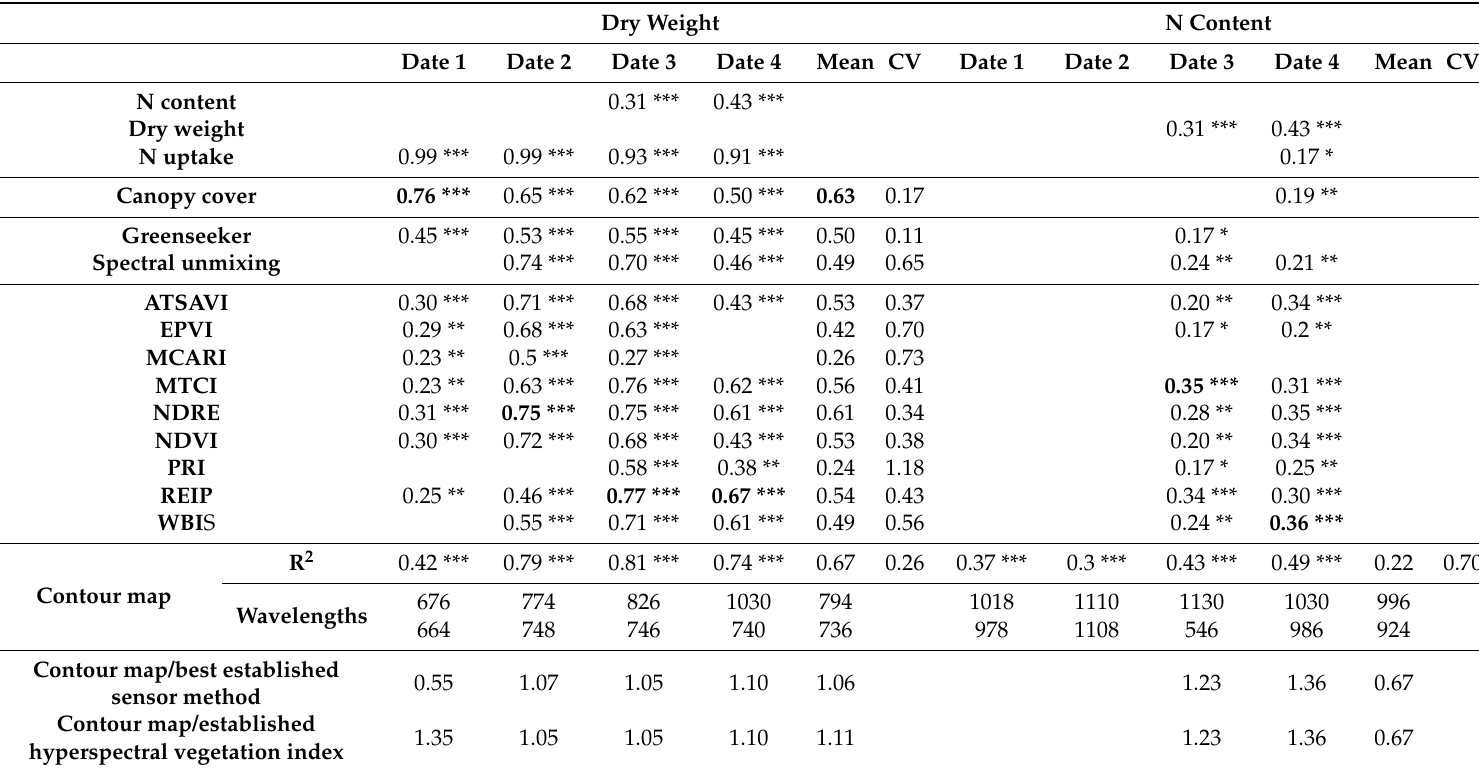
Table 3. Squared Pearson correlation coefficients (R 2 ) and significance levels (<0.05) for linear relationships of the sensor methods with canopy traits for four measurement dates as well as pairwise relationships of canopy traits. The R 2 of the best established sensor method per canopy trait is highlighted in bold for each date. Non-significant relationships are not shown. Contour map results refer to the maximum R 2 extracted from all possible pairwise normalized difference indices. For each trait*sensor method combination, the mean and coefficient of variation (CV) of the R 2 was calculated across the four days including non-significant relationships, except for NC because the correlations were often not significant. For contour maps, however, the values refer to the maximum of the mean contour map matrix as averaged over four days and the CV of the respective index for accounting for changes in optimum band combinations over time. The ratio of the best contour map correlation to the best correlation found form all other established sensor methods and from the established hyperspectral vegetation indices is given as measure of gain through using optimized vegetation indices. Wavelengths included in contour map indices are indicated. Horizontal table lines group traits from top to bottom into target traits and different types of predictor